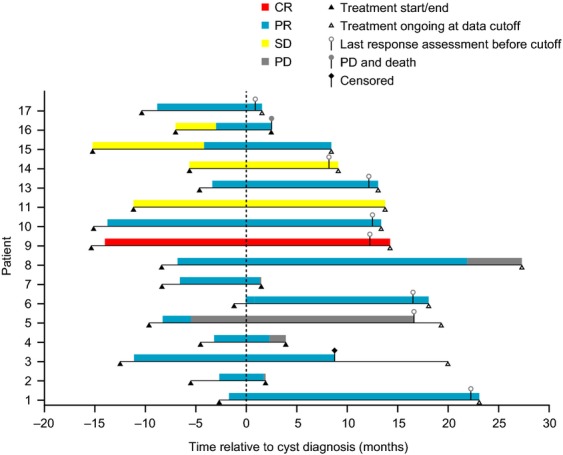
Treatment and responses at data cutoff (31 December 2012) in patients with renal cysts reported as serious adverse events. Cyst diagnosis dates were based on radiologic assessment at the study sites. Derived response data are depicted per RECIST. Relevant data were not available for patient 12. RECIST, response evaluation criteria in solid tumors.